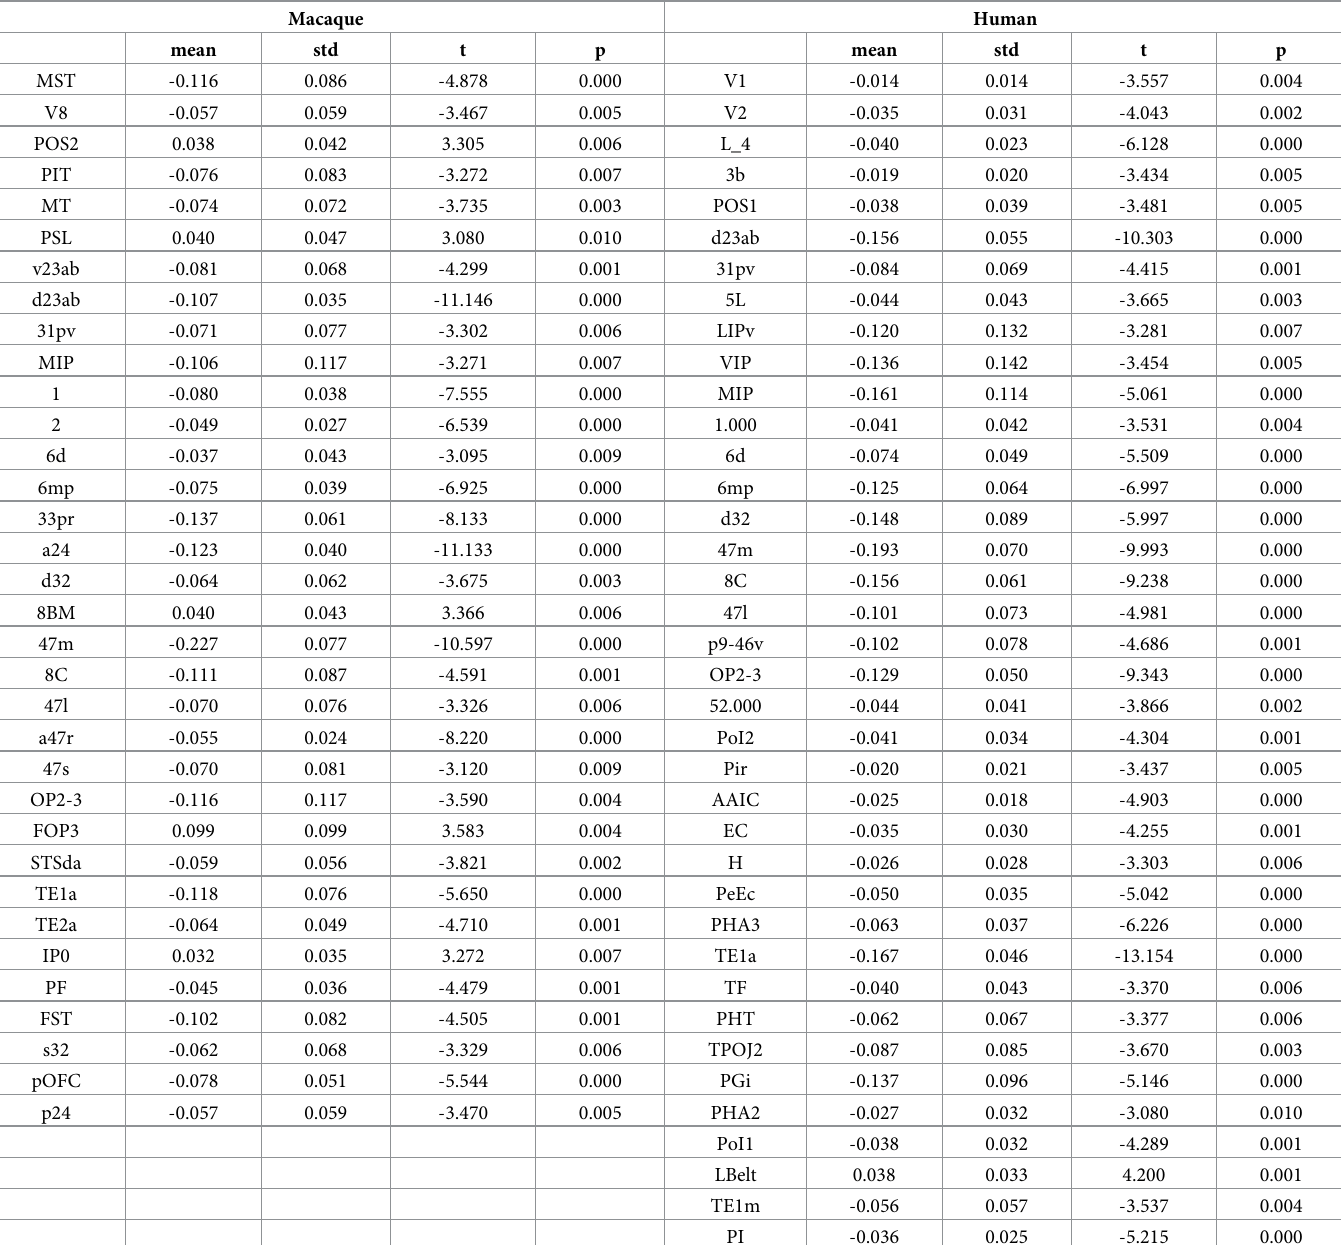
Table 1. Interhemispheric areal